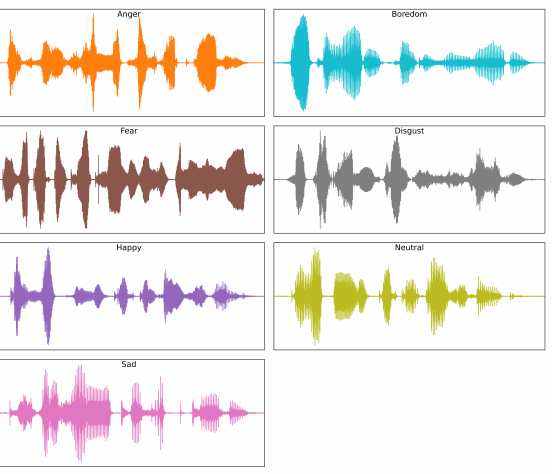
Figure 3. The waveforms representing each emotion in the EMO-DB